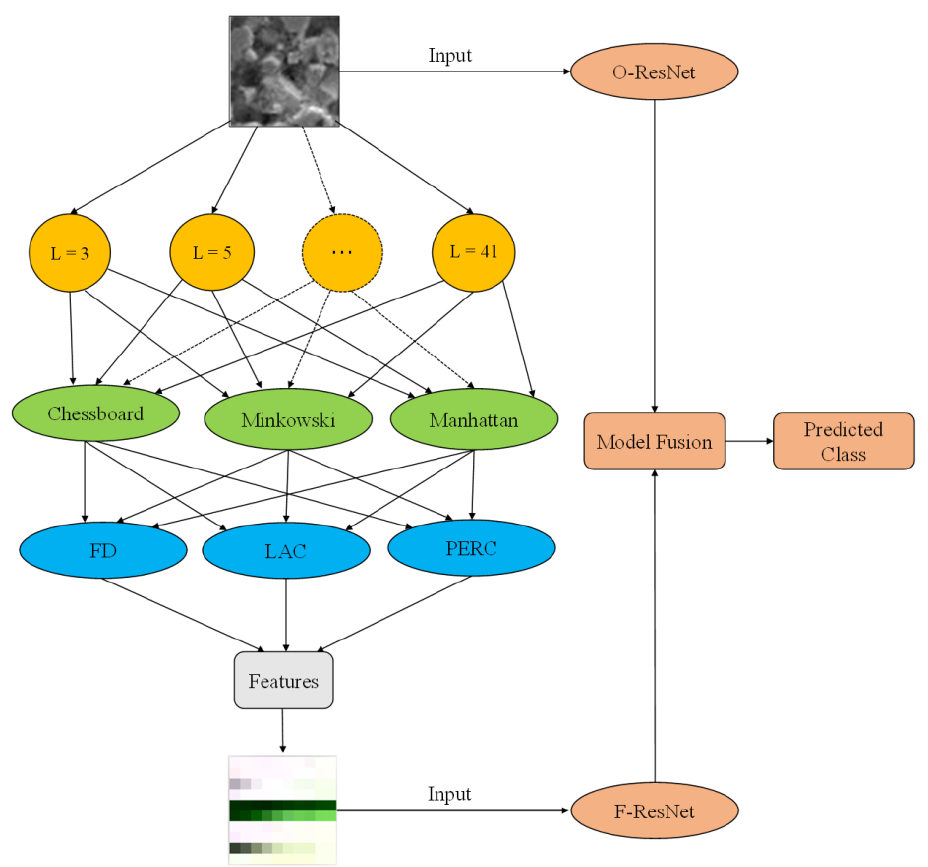
Figure 6. The process of image feature extraction and classification for the oxidized surface after thermal shocks, including the O-ResNet model, F-ResNet model, and fusion model.